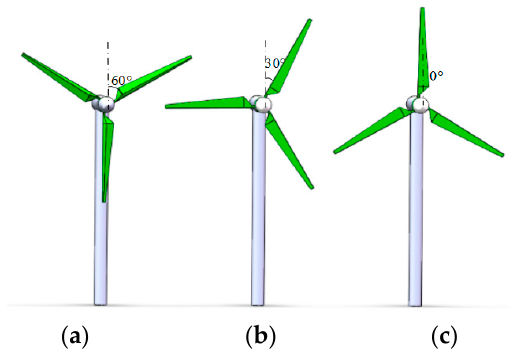
Figure 4. Typical position of static blade: ( a ) θ = 60°; ( b ) θ = 30°; ( c ) θ = 0°.